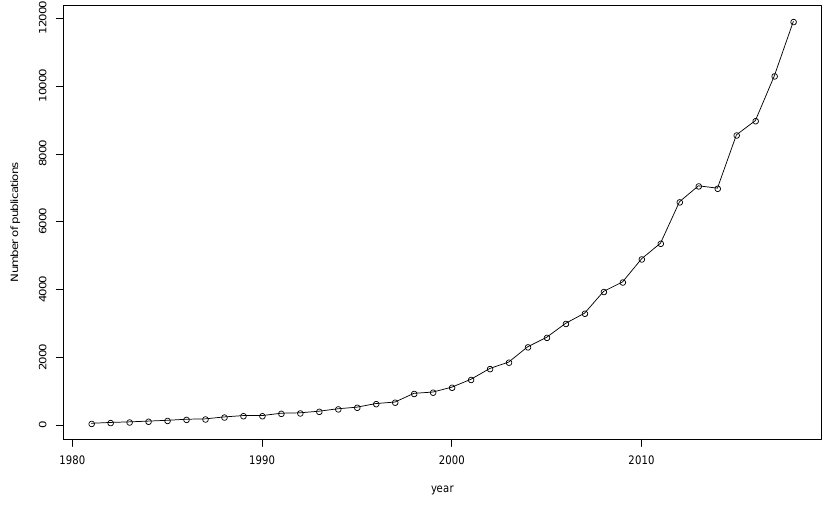
Figure 1. Yearly number of new publications listed on Google Scholar containing the keywords “mixed reality” and “robots” (date of acquisition: 13 March